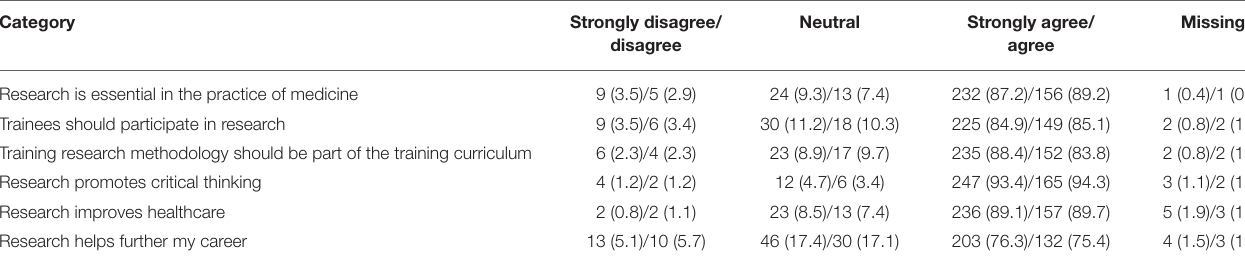
TABLE 4 | Attitudes toward research. ( N , %), second value indicates females. Category Strongly disagree/